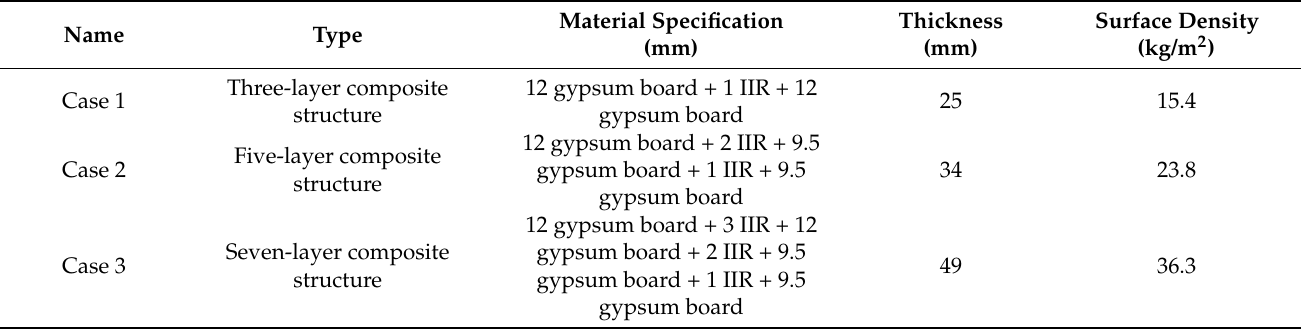
Table 1. Simulated composite partition specifications and